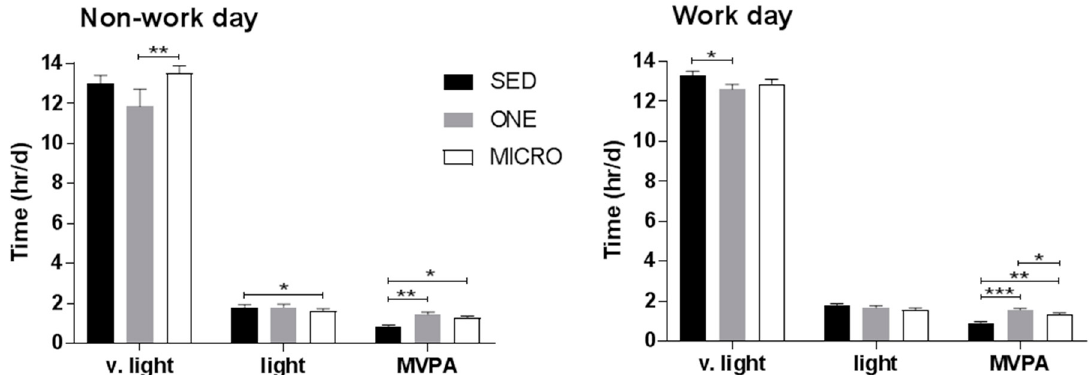
Figure 2. Waking time per day performing very light, light and moderate-to-vigorous intensity physical activity. Accelerometry data collected from ActiGraph GT3X tri-axial accelerometer are displayed by location (work or non-work day) and by physical activity intensity. V. light, very light intensity physical activity; MVPA, moderate-to-very vigorous intensity physical activity; SED, sedentary condition; ONE, one-bout intervention; MICRO, microbouts intervention. * p < 0.05, ** p < 0.01, *** p < 0.0001 vs. sedentary control condition.